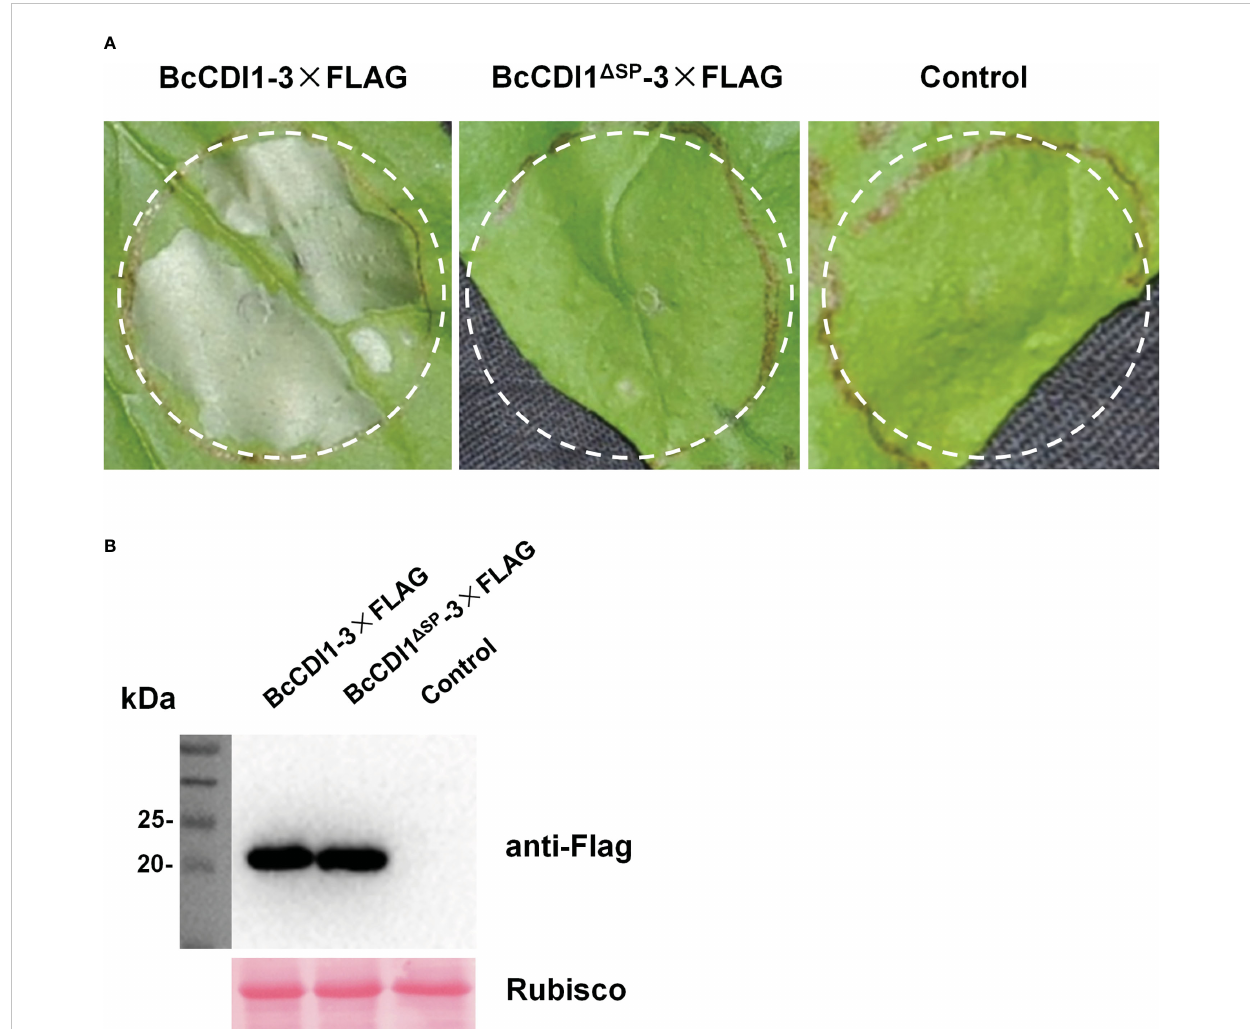
FIGURE 1 Full-length BcCDI1 can induce cell death, and the signal peptide is required for its function. (A) Images of Nicotiana benthamiana leaves at 5 days after agroin fi ltration with Agrobacterium tumefaciens strains carrying the indicated constructs. Agrobacterium tumefaciens carrying the empty vector was used as the control. BcCDI1-3×Flag, BcCDI1 fused with 3×Flag at the C-terminus; BcCDI1 D SP -3×Flag, BcCDI1 without the signal peptide fused with 3×Flag at the C-terminus. (B) Immunoblot analysis of proteins from N. benthamiana leaves with transient expression of the indicated constructs. Top panel, immunoblot using anti-Flag antibody; bottom panel, staining of the Rubisco large subunit with Ponceau